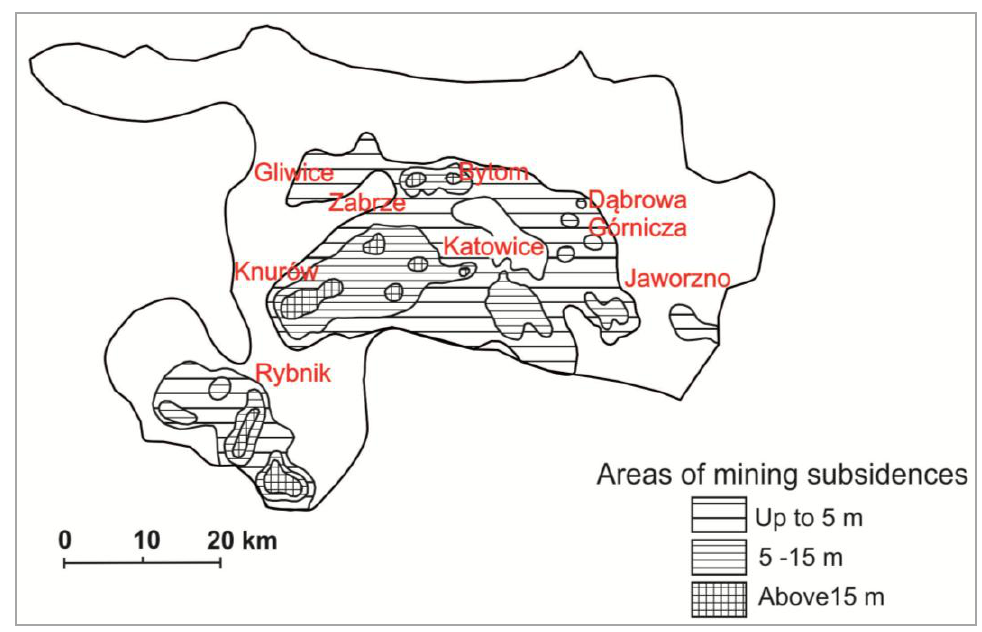
Fig. 5. Range of mining subsidences within the zone of black coal exploitation in the Silesian Upland (after Dwucet et al., 1992, changed)